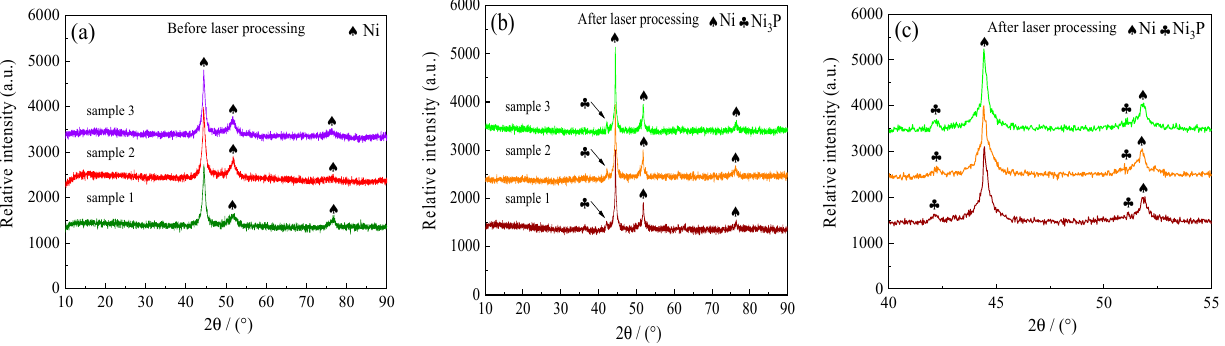
Figure 20. XRD patterns of samples before and after laser processing: ( a ) before laser processing; ( b , c ) after laser processing.